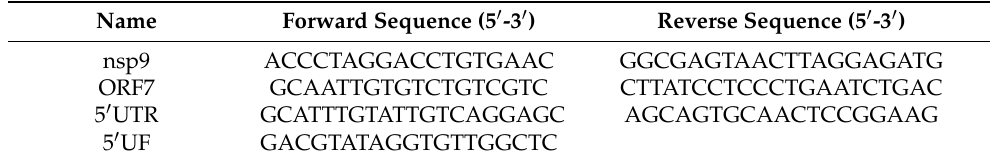
Table 1. The sequences of primers used in this